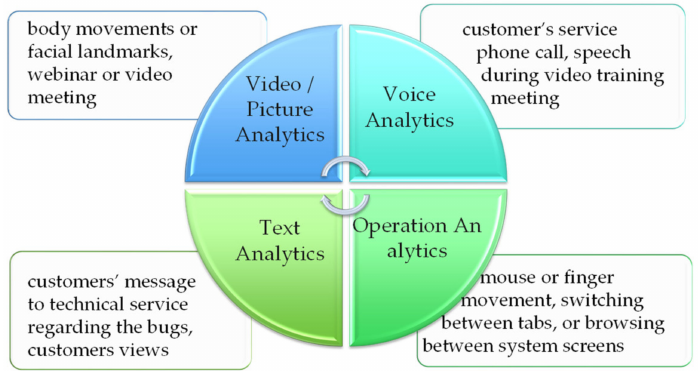
Figure 2. Data sources for customer’s emotional motivator